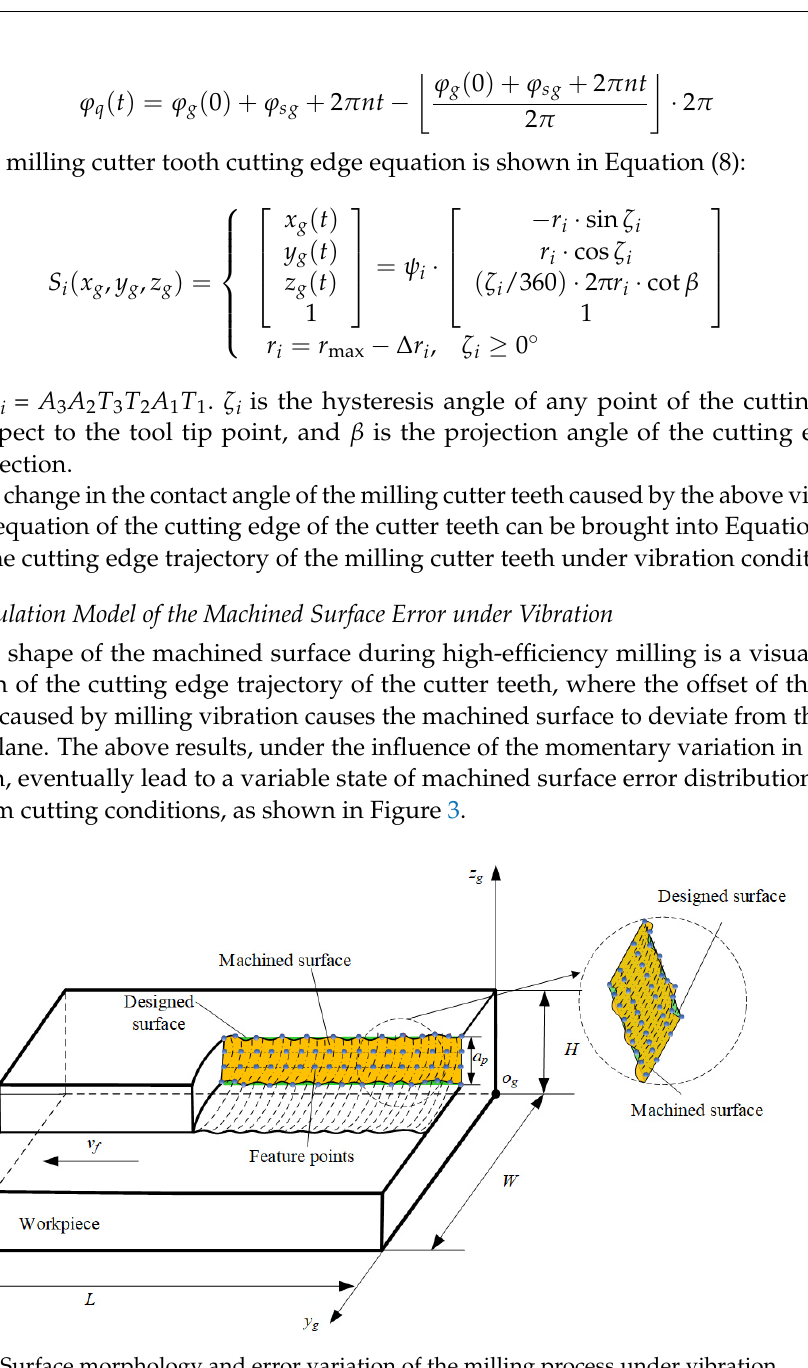
Figure 3. Surface morphology and error variation of the milling process under vibration.